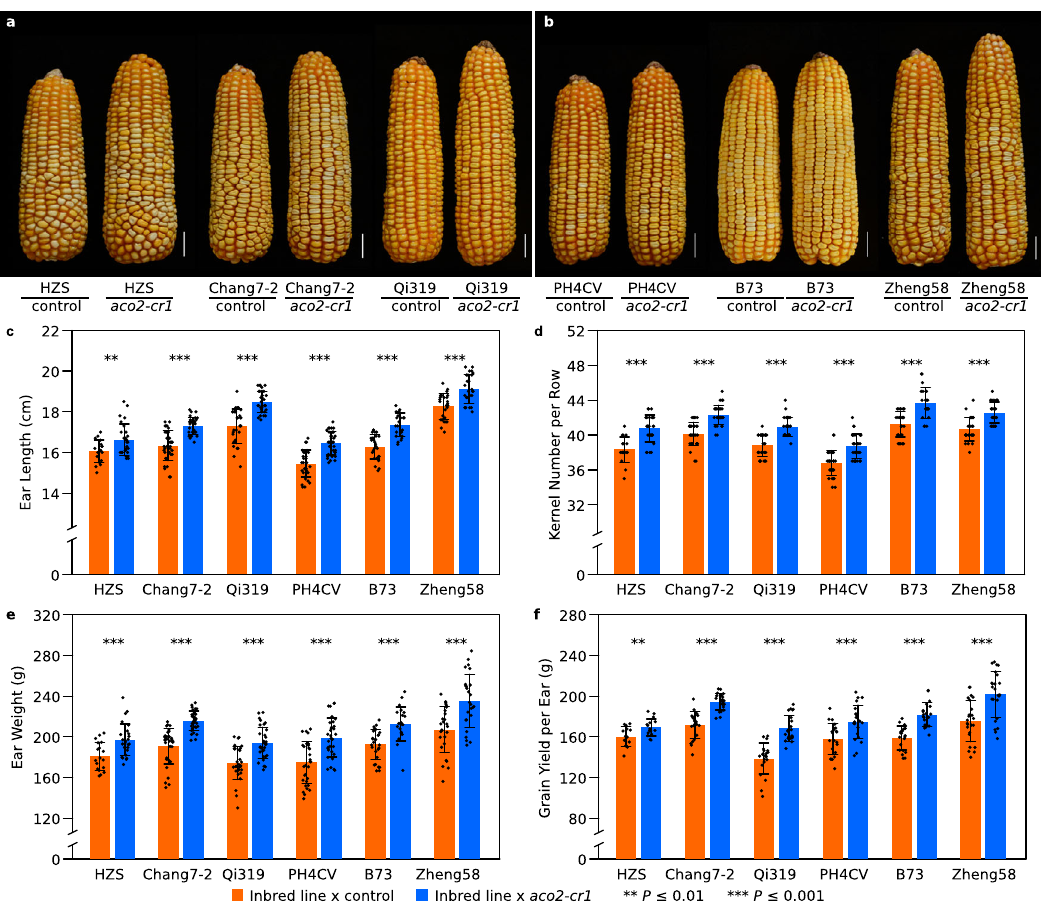
Fig. 6 aco2-cr1 null allele enhances yield-related traits in diverse hybrid backgrounds. Hybrids of “ aco2-cr1 × inbred line ” made longer ears with more kernels than “ sibling control × inbred line ” hybrids. Diverse inbred lines were crossed to aco2-cr1 and its sibling control; representative mature hybrid ears of aco2-cr1 and its sibling crossed with three Hap SL17 inbred lines ( a ) and three Hap Ye478 inbred lines ( b ); scale bar = 5 cm. c − f Performance of hybrids ( a , b ) in grain ear-traits including ear length ( c , p = 0.0053, 3.14 × 10 − 9 , 2.15 × 10 − 9 , 9.50 × 10 − 9 , 2.50 × 10 − 8 and 1.33 × 10 − 5 respectively), kernel number